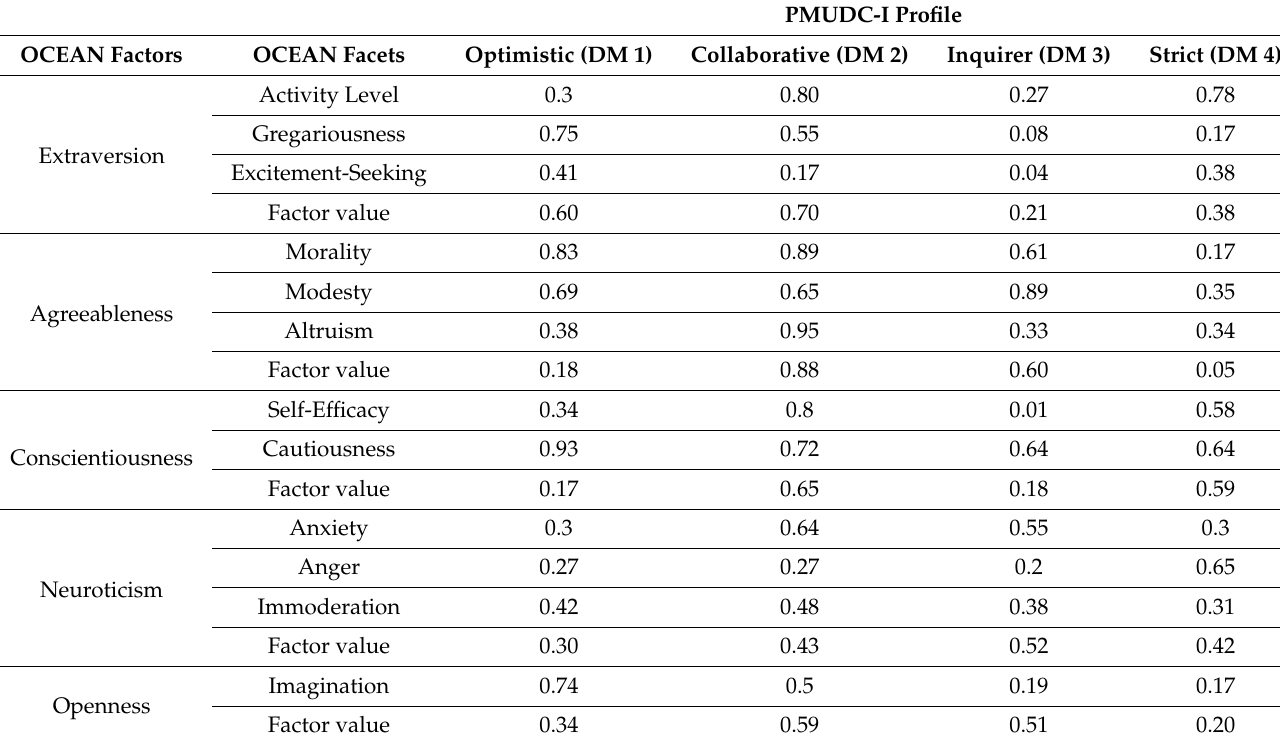
Table A3. Results of the IPIP-NEO questionnaire [26] belonging to the four DM under study. PMUDC-I